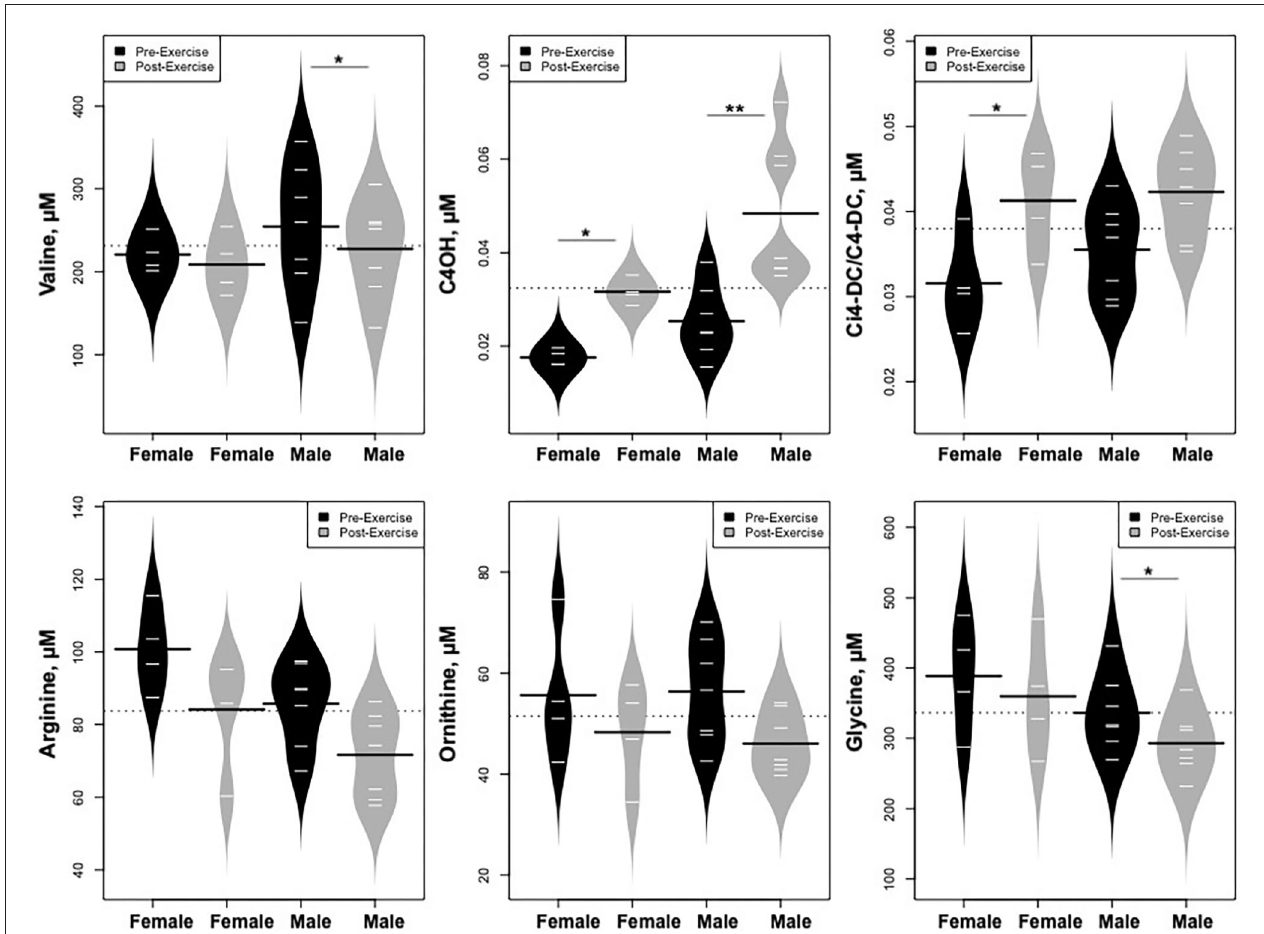
FIGURE 8 | Changes in metabolites related to BCAA catabolism and urea cycle, stratified by sex. * p < 0.01, ** p < 0.001.